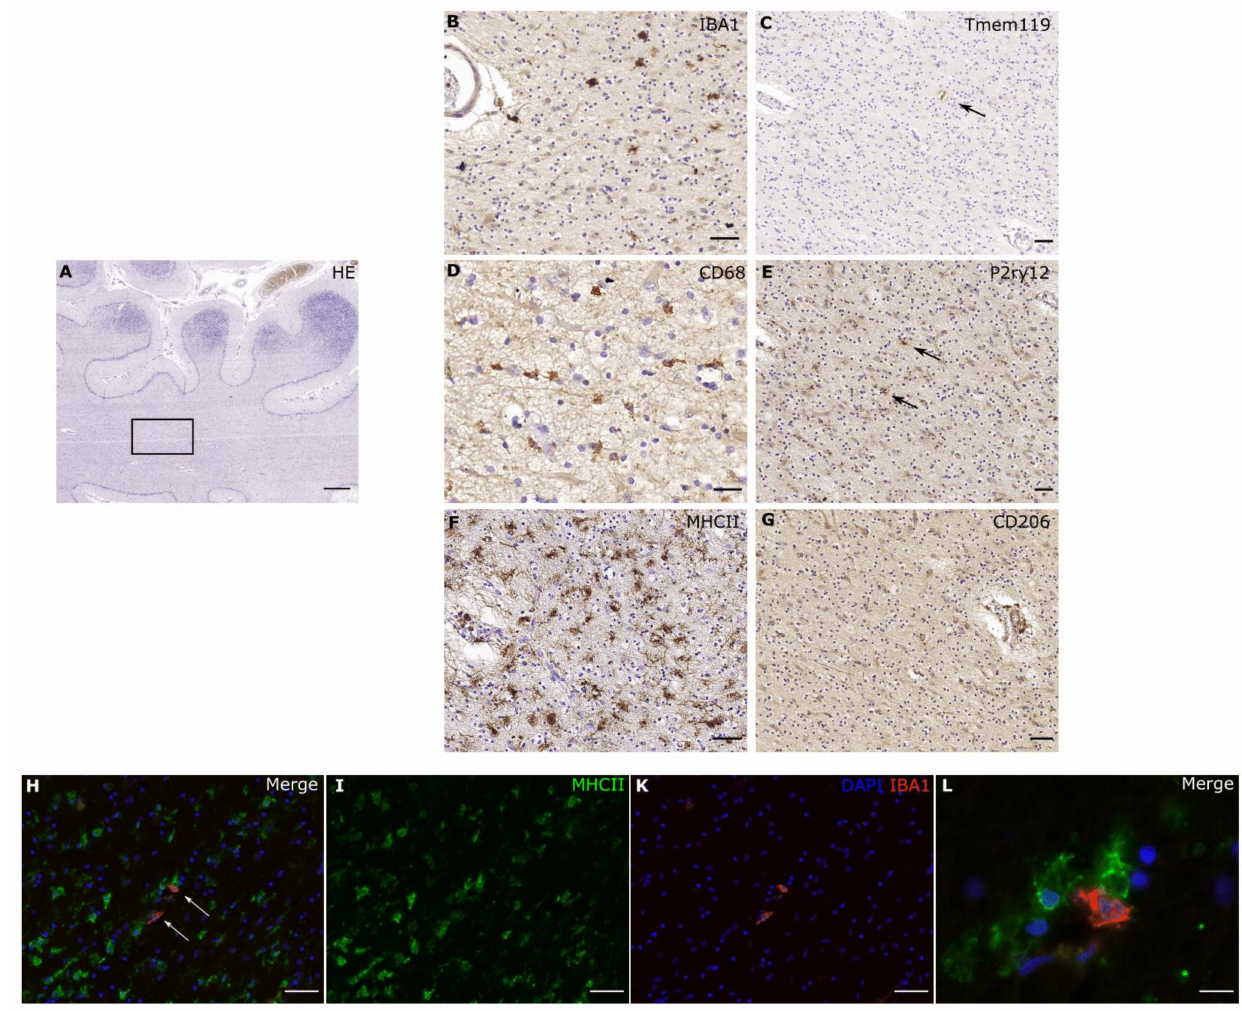
Figure 3. Pronounced morphological activation of microglial cells. In a case with hypoxic brain damage after CPR, one can detect pronounced activation and high phagocytic activity. We see a strong expression of MHCII ( F ) and CD68 ( D ), while IBA1 ( B ) is expressed, but the number of IBA1-positive cells is visibly reduced. Homeostatic markers such as TMEM119 ( C ) and P2RY12 ( E ) display only a residual expression ( ↑ ). However, CD206 ( G ), a marker for peripheral macrophages, stays negative, therefore a distinct recruitment of non-cns macrophages seems unlikely. In the immunofluorescence, the majority of cells express MHCII, while only two cells express IBA1. Interestingly, microglial cells with different expression profiles are located in direct vicinity from each other. Scale bars: ( A – C ), ( E – K ): 50 µ m, ( D ): 20 µ m, ( L ): 10 µ